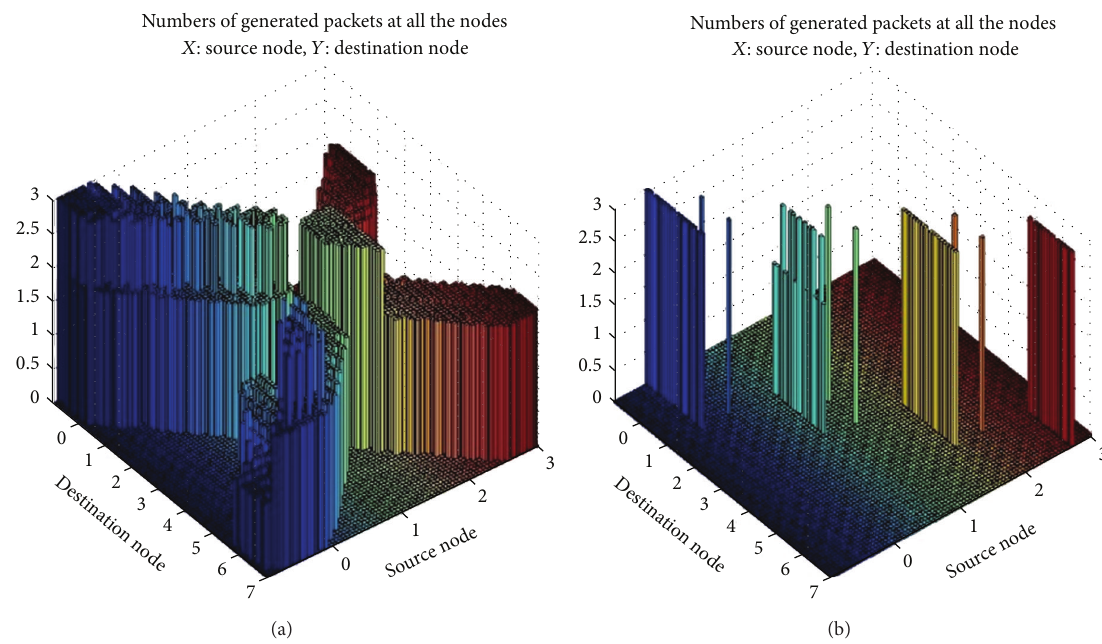
Figure 2: Number of generated packets with and without cooperation